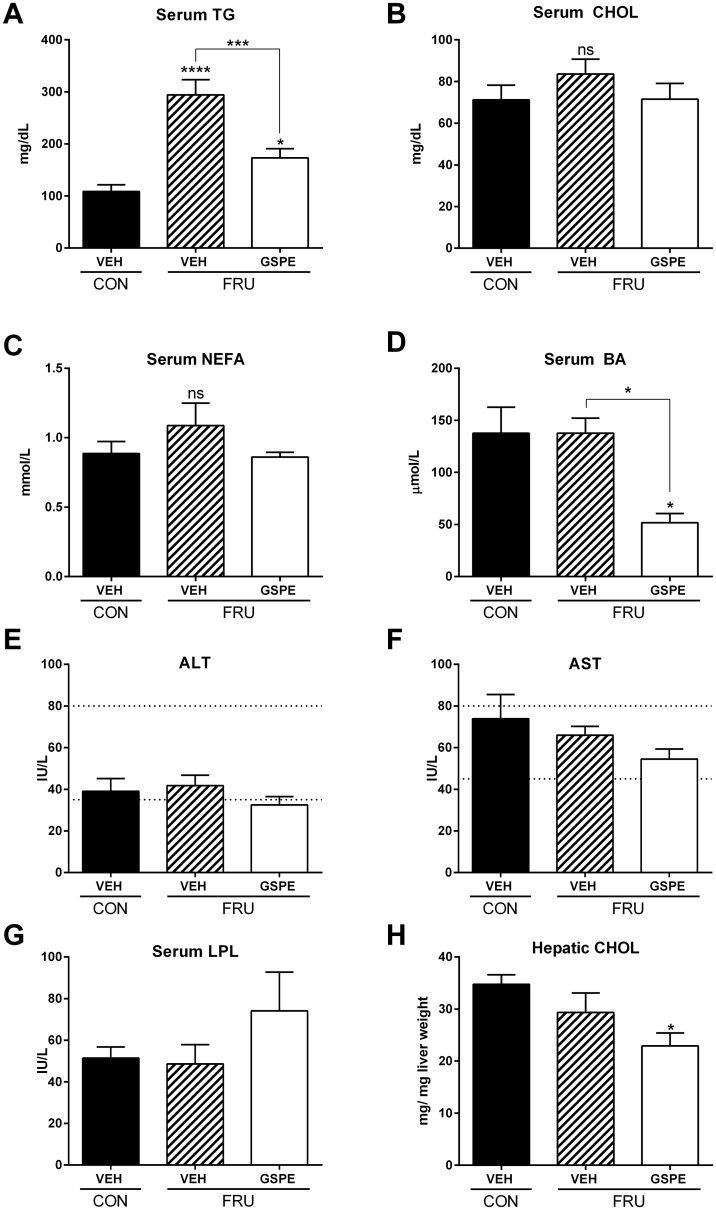
Serum biochemical analysis and hepatic cholesterol content.Serum was analyzed for (A) triglycerides (TG) (B) cholesterol (CHOL), (C) non-esterified fatty acids (NEFA), (D) bile acids (BA), (E) Alanine aminotransferase (ALT), (F) aspartate aminotransferase (AST); the dotted lines represent the normal upper and lower limits respectively. (G) lipoprotein lipase activity (LPL), and (H) hepatic cholesterol content (CHOL). *p<0.05, ***p<0.001 and ****p<0.0001.